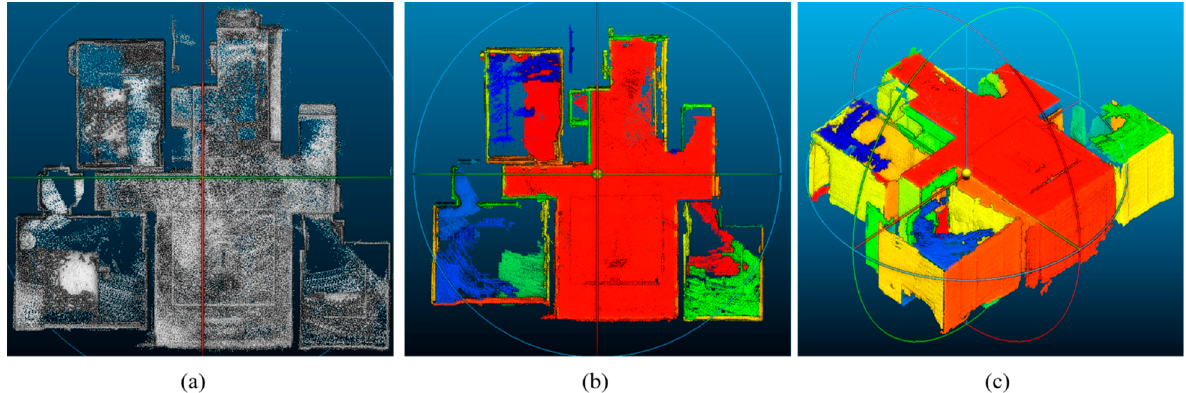
Figure 14. Implementation results of Dataset #3. ( a ) Raw PCD; ( b ) Top view of detected building components; ( c ) Front isometric view of detected building components.